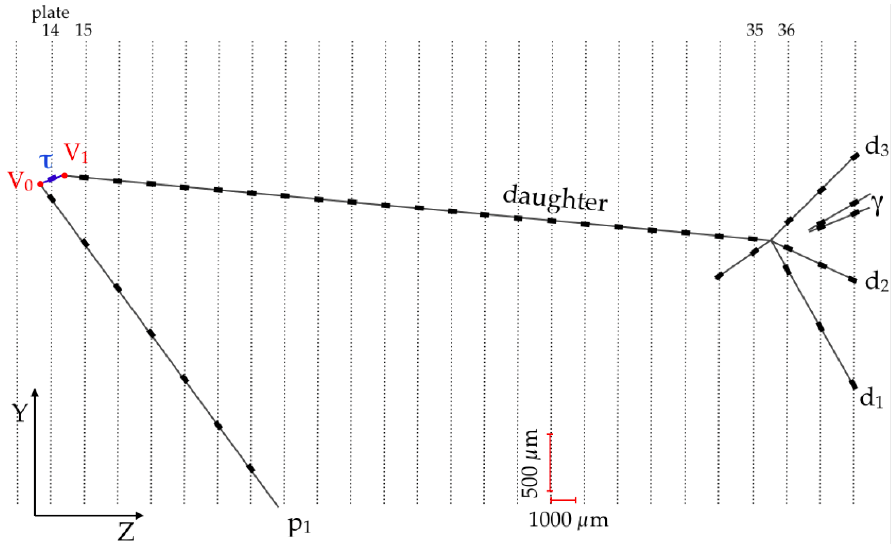
Figure 2. The 5th τ candidate ( τ → h ) observed in one of the OPERA ECC in